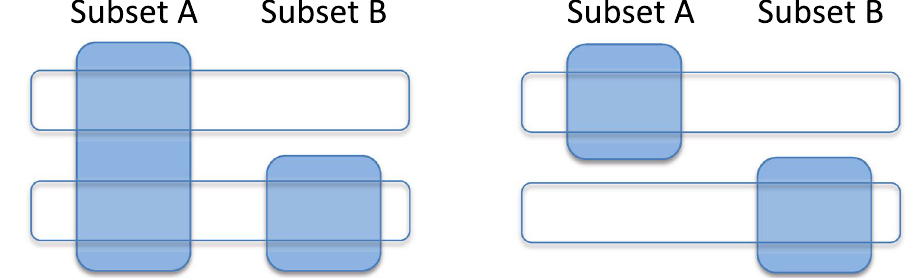
Figure 6. One subset, one circuit in the primitive nervous system. Neuron subset is a molecularly defined group of neurons expressing a common marker gene set. A neuron circuit is a physiologically defined group of neurons, firing simultaneously to function. Usually, a neuron subset harbors multiple neuron circuits in an advanced nervous system while a neuron subset harbors a single neuron circuit for their motor function in Hydra